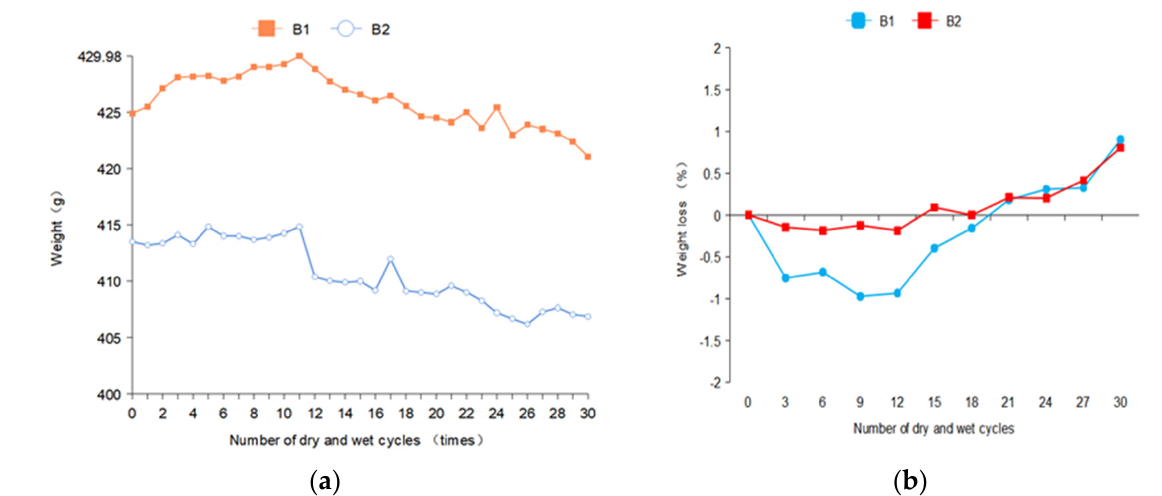
Figure 4. Mass changes of concrete specimens. ( a ) Mass loss curves of B1 and B2 concrete specimen ( b ) The mass loss rate curves of B1 and B2 concrete specimens were obtained.